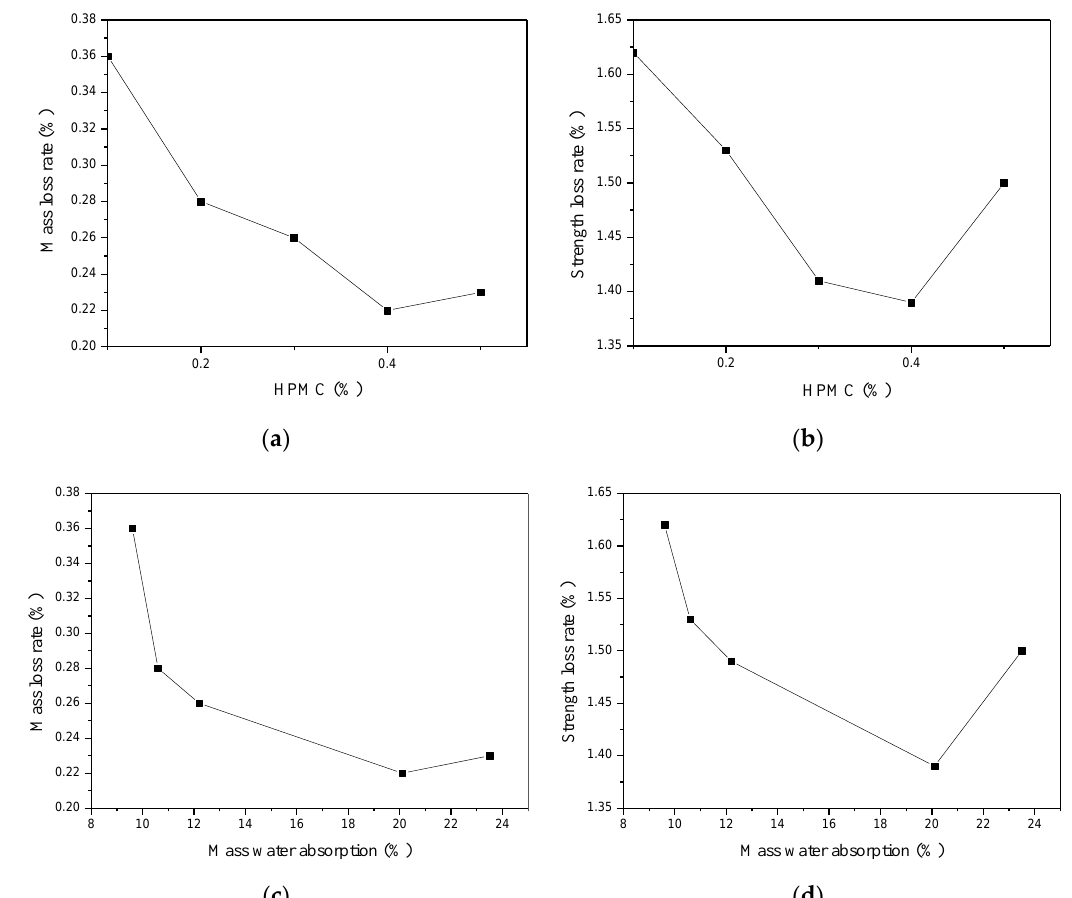
Figure 12. The regular pattern of frost resistance. ( a ) mass loss rate; ( b ) strength loss rate; ( c ) water absorption-mass loss; ( d ) water absorption-strength loss.